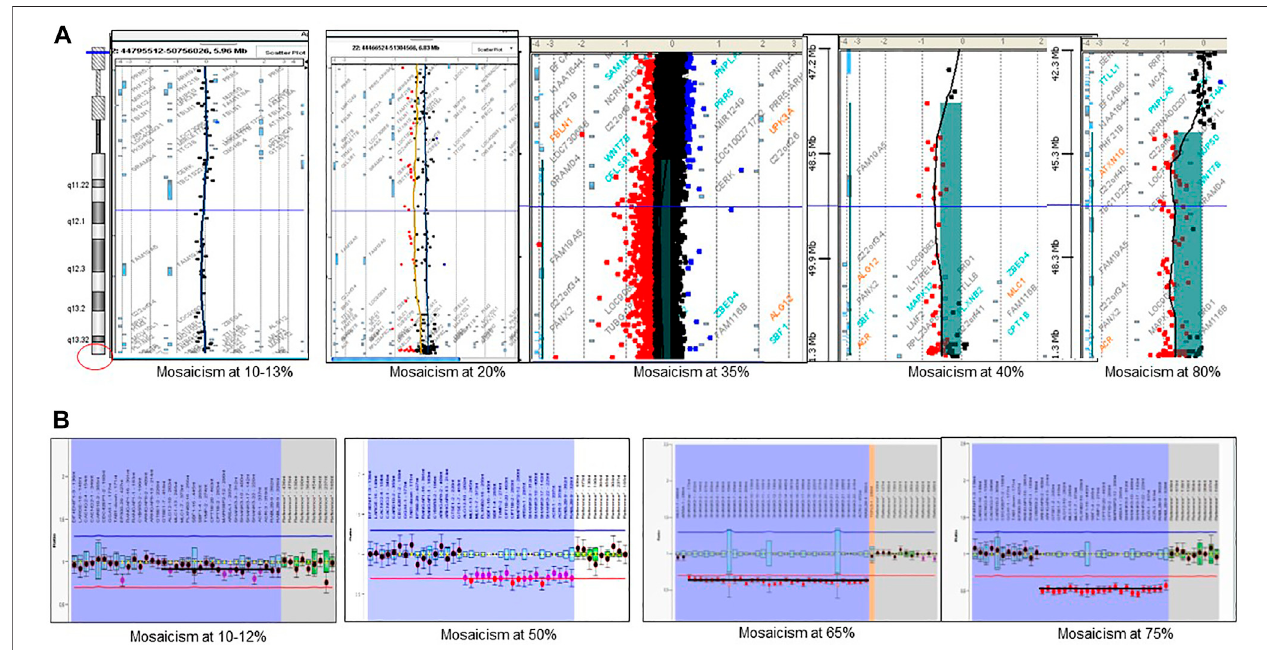
FIGURE 5 | Detection of post-zygotic mosaicism in PMS by using microarrays and MLPA. (A) examples of mosaicism detected by CGH-array; (B) examples of mosaicism detected by MLPA.